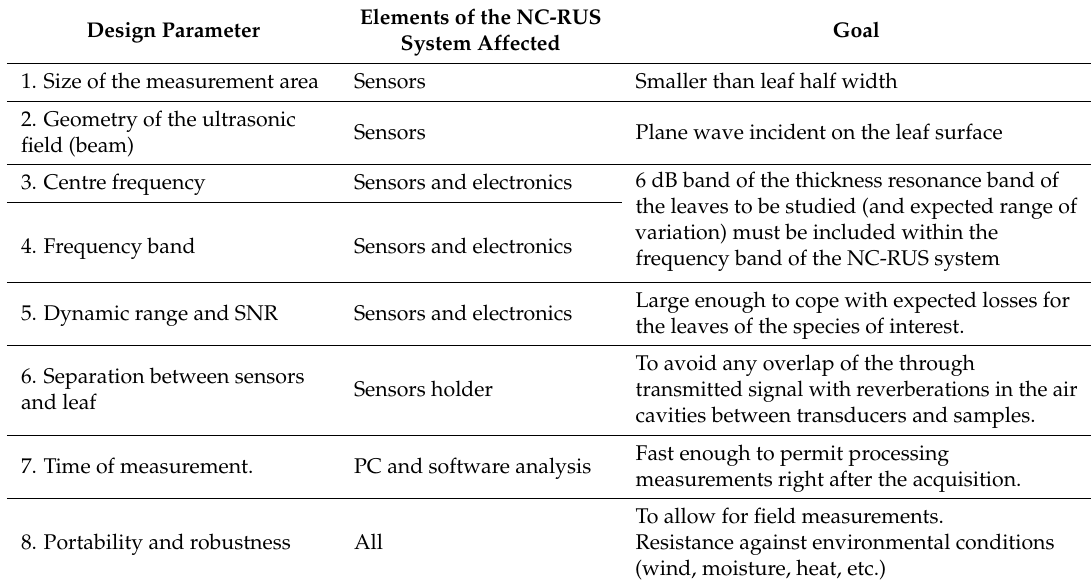
Table 1. Summary of the main design criteria and elements of the NC-RUS system affected.